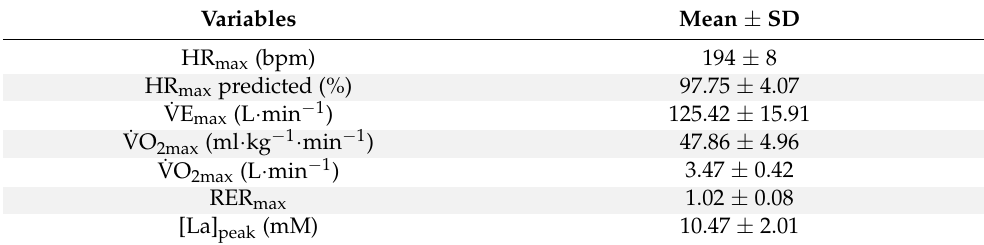
Table 1. Maximal physiological characteristics of participants at CPxS.